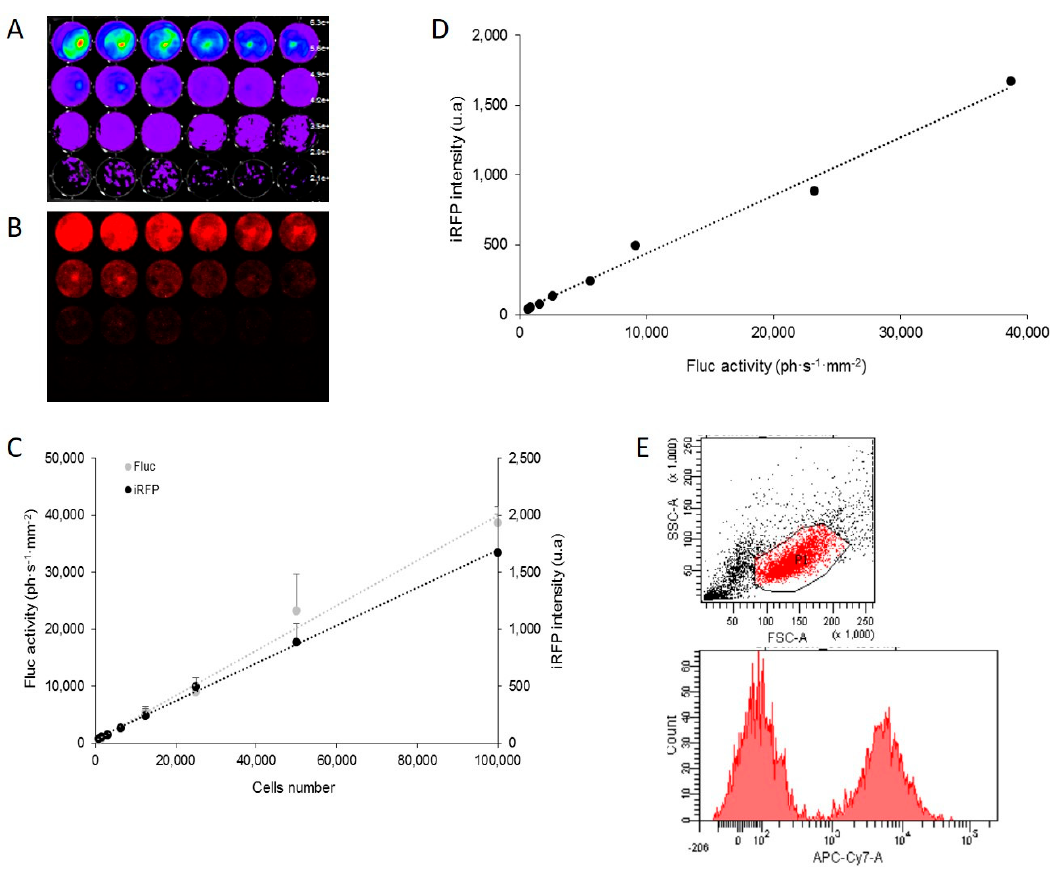
Figure 1. In vitro correlation between firefly luciferase (Fluc) activity and infrared fluorescent protein (iRFP) expression in U87-iRFP+-Fluc+ cells. Bioluminescence imaging (BLI) ( A ) and fluorescence reflectance imaging (FRI) ( B ) of successive dilutions (1:2) of U87-iRFP+-Fluc+ cells (from 781 to 100,000 cells) two days after plating. Fluorescent signals of iRFP and Fluc activities were plotted versus cell number ( C ). Fluorescent signals of iRFP were plotted versus bioluminescence signals ( D ). Representative distribution of iRFP-expressing cells ( E ) was determined by flux cytometry (10,000 cells). u.a, units arbitrary.